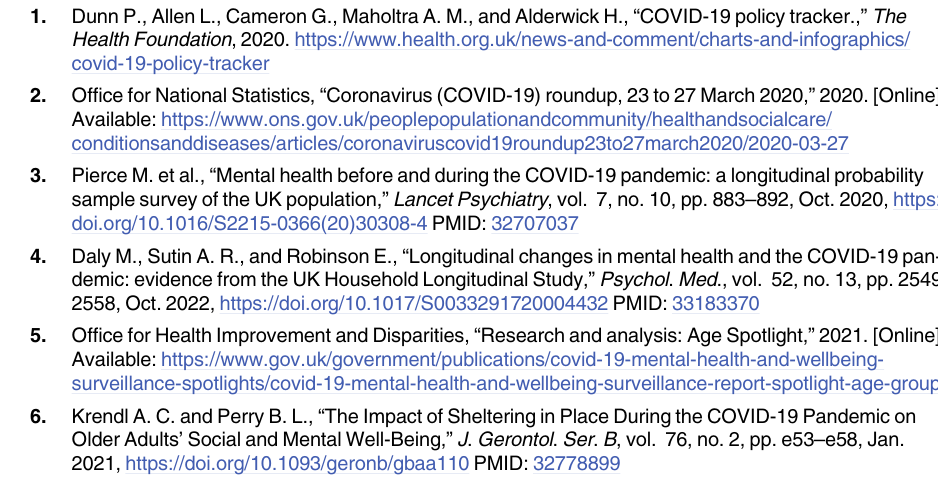
S2 Fig. Interview guide example questions and prompts pertinent to the research question. S1 Table. Timeline of COVID-19 restrictions in UK between 2020 and 2021 and propor- tion of study interviews conducted in each